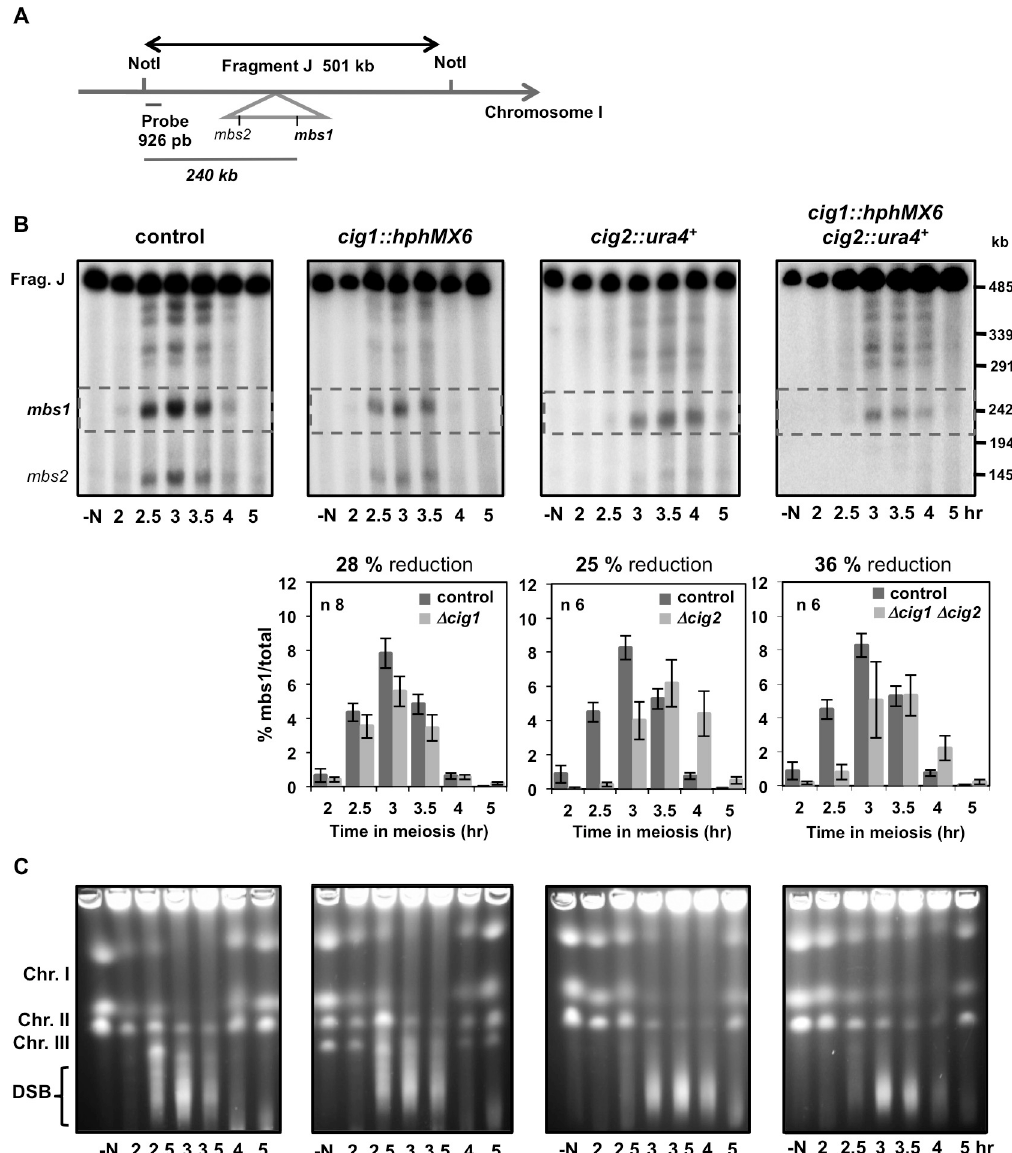
Fig 2. DSB formation in cig1 , cig2 , and cig1 cig2 deletion mutants. (A) Scheme of chromosome position of the mbs1 hotspot and probe used for break detection. (B) Detection of mbs1 breakage by Southern blot in control (CMC7), cig1 (CMC1010), cig2 (CMC1022), and double cig1 cig2 (CMC1023) deletion mutants during synchronous meiosis of pat1-114 diploids; representative blots are shown. Below each blot the percentage of breakage is represented as the mean +/- SEM of n independent experiments. Each mutant was analyzed with the control kinetics in the same experiment. p values (maximal percentage of breakage) were calculated based on Student´s t-test (unpaired, two tails): 0.094 cig1 mutant, 0.210 cig2 mutant, and 0.060 double cig1 cig2 mutant. (C) PFGE separation of entire chromosomes during meiotic kinetics. DSBs are visualized as a transient smear below the chromosomes. Control and cig1 experiments were analyzed in the same gel and therefore similarly stained and subjected to the same image processing. cig2 and double cig1 cig2 mutants were analyzed in the same gel and therefore similarly stained and subjected to the same image processing. Images were adjusted to show similar signal in chromosomes at the initial time point